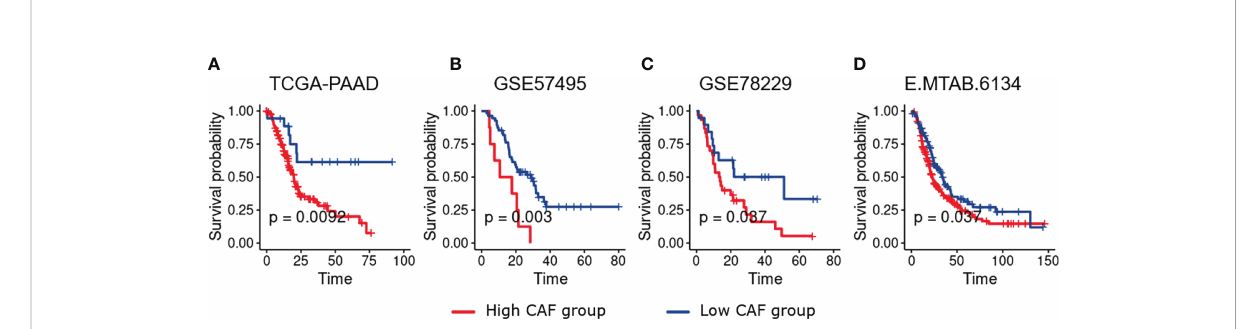
FIGURE 1 Kaplan – Meier plots of PDAC patients dichotomized based on the in fi ltration CAF scores calculated using MCP_Counter. Based on the survival analysis, higher CAF In fi ltration is associated with worse overall survival in PDAC patients. (A – D) , Represent TCGA-PAAD, GSE57495, GSE78229, and E-MTAB-6134